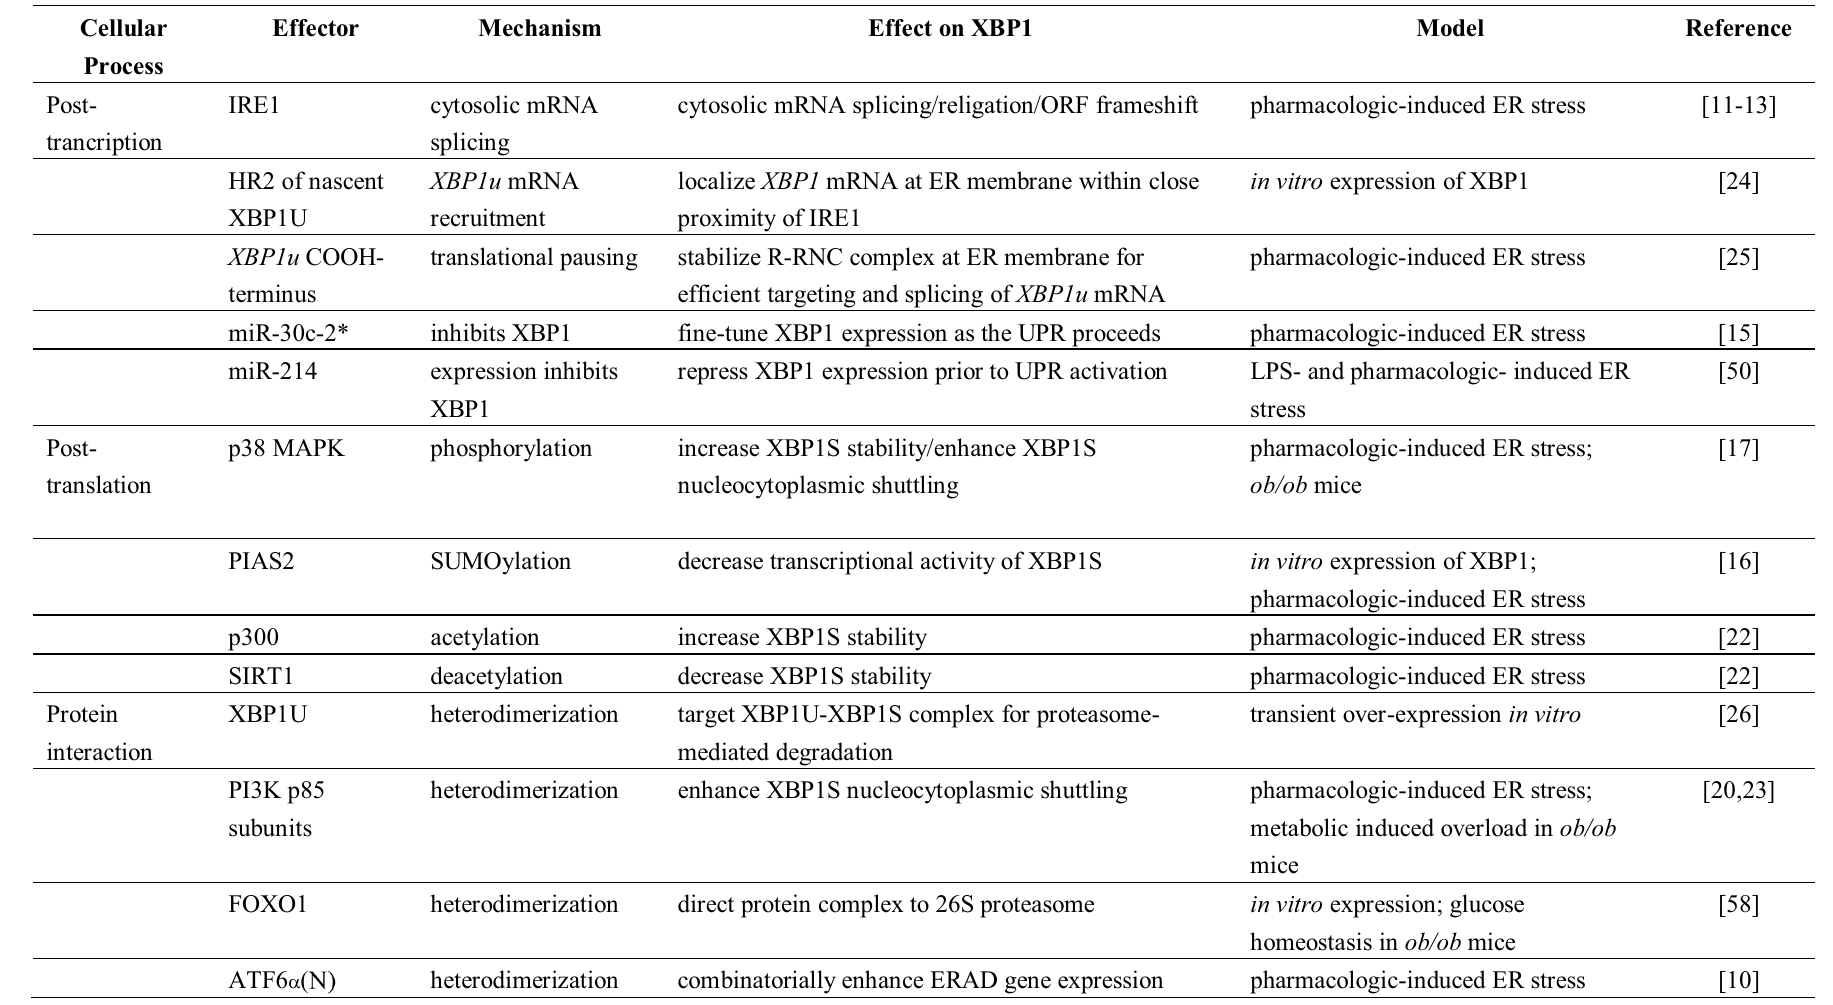
Table 1. Molecular mechanisms modulating XBP1 expression and activity. Overview of reported regulatory mechanisms for the XBP1 transcription